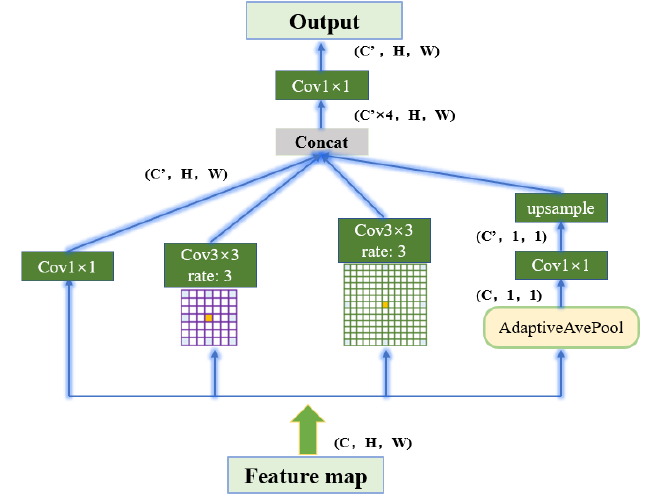
Figure 6. Atrous spatial pyramid pooling.